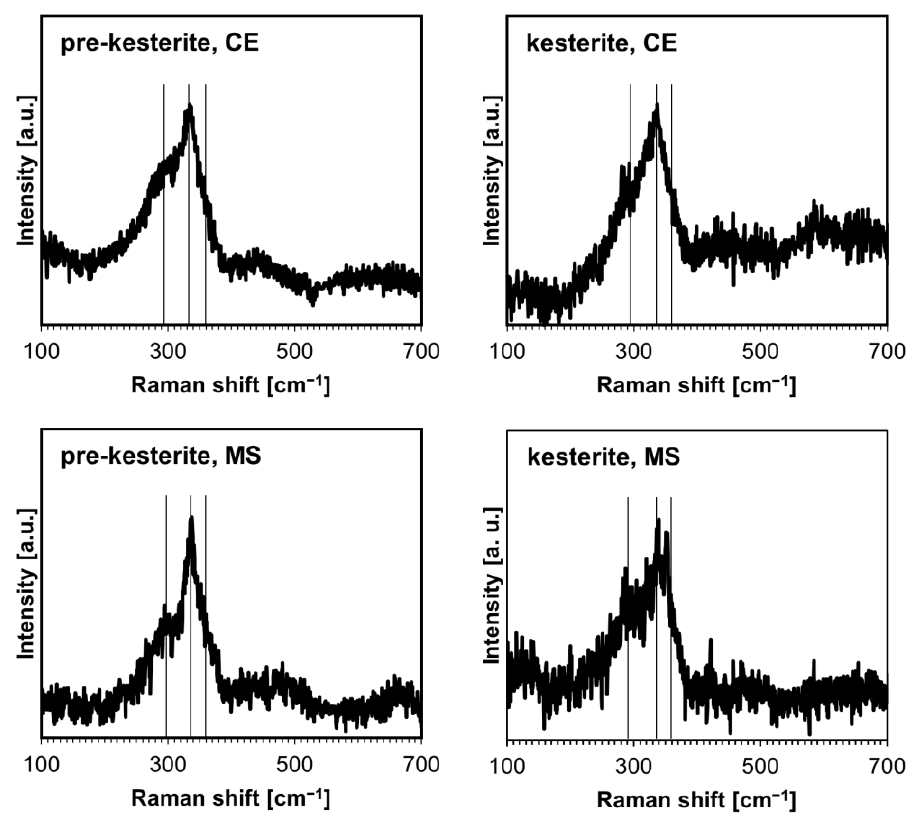
Figure 10. Raman spectra for sintered pellets from prekesterite and kesterite in the CE system ( top row) and MS system ( bottom row). Vertical lines indicate the approximate positions of the characteristic Raman